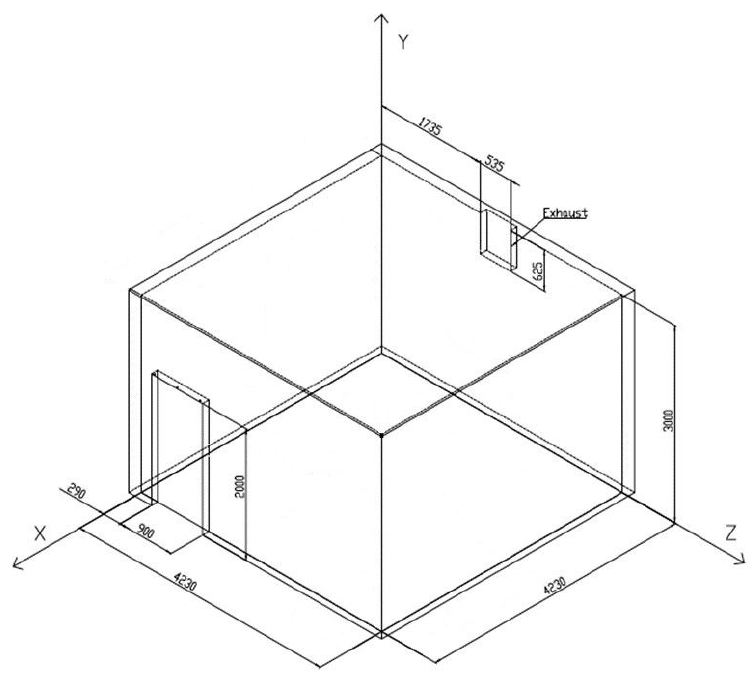
Figure 2. Full-size test compartment (mm).